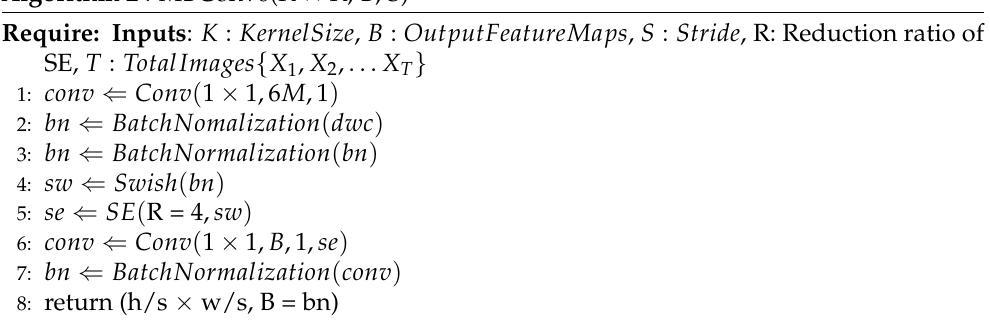
Algorithm 2 : MBConv6(K × K, B, S)